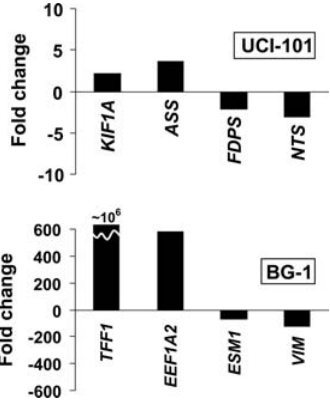
Figure 5. Validation of illumina arrays data for let-7f . Transcripts identified by illumina arrays to be altered following let-7f overexpres- sion are validated by RT-PCR. Fold changes for genes KIF1A, ASS, FDPS, NTS (in UCI-101 cells), and TFF1 , EEF1A2, ESM1, VIM (in BG-1 cells) are shown and confirm the changes identified by illumina arrays.